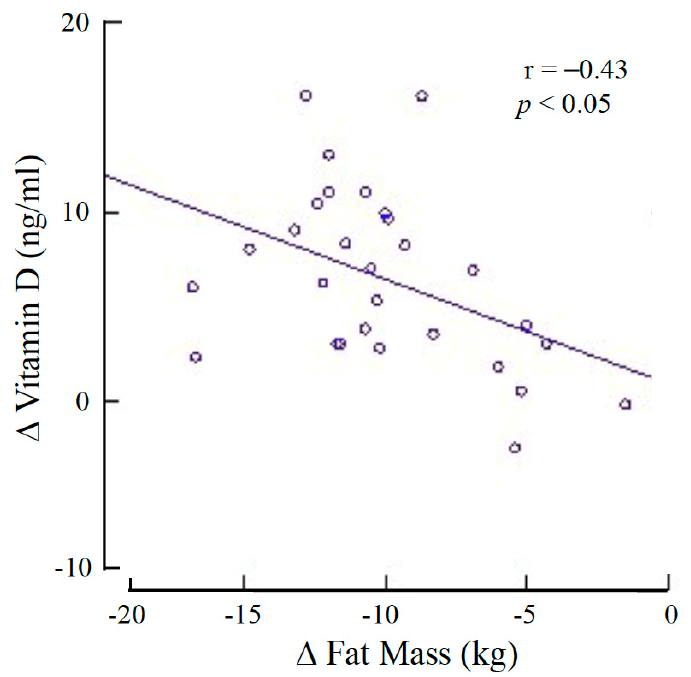
Figure 2. Correlation between the change ( ∆ ) in serum concentrations of 25-hydroxy vitamin D and that of fat mass in people with obesity following very low-calorie ketogenic diet. Table 2. Fasting serum concentration of the hormonal and biochemical variables of patients with obesity before and after dietary treatment.